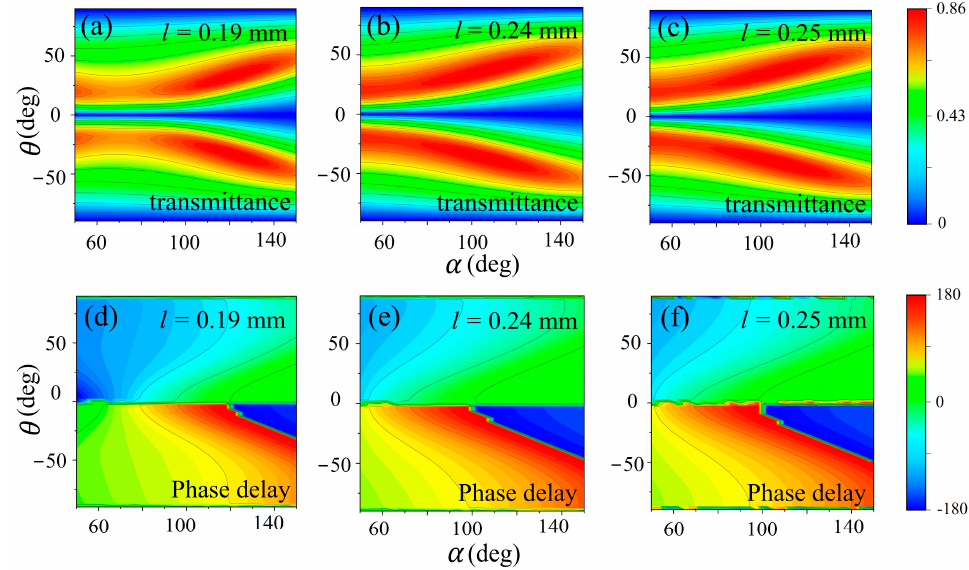
Figure 2. Transmittance ( a – c ) and phase delay ( d – f ) as functions of the opening size α , and opening direction θ for the outer radius R = 0.34 mm . direction θ for the outer radius R = 0.34